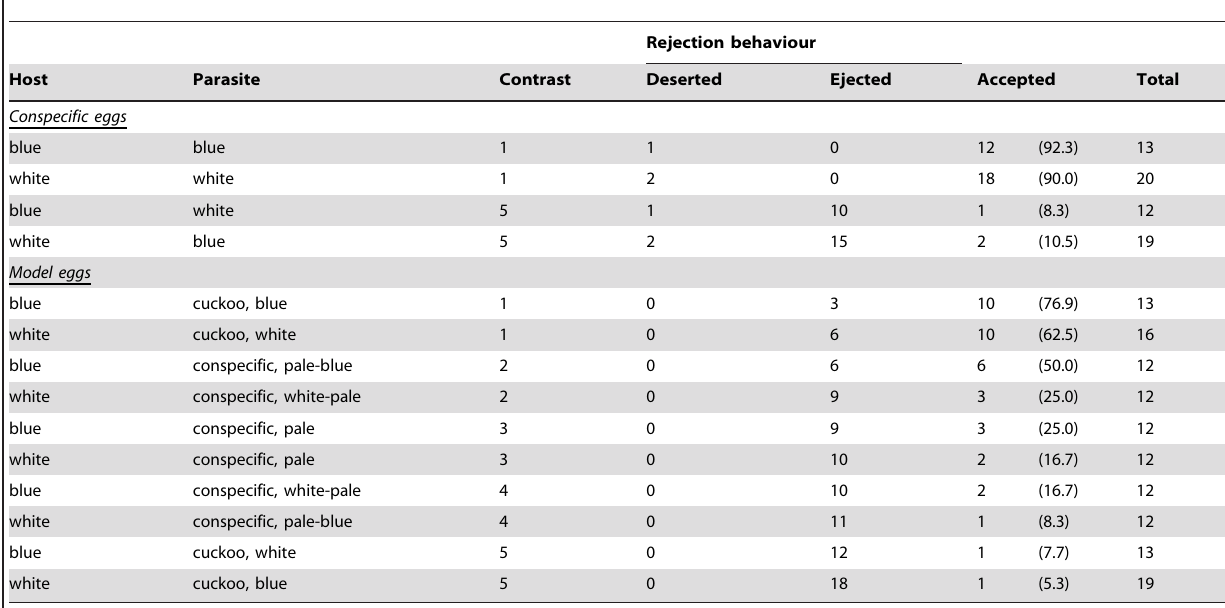
Table 1. Results from experimental parasitism of ashy-throated parrotbill